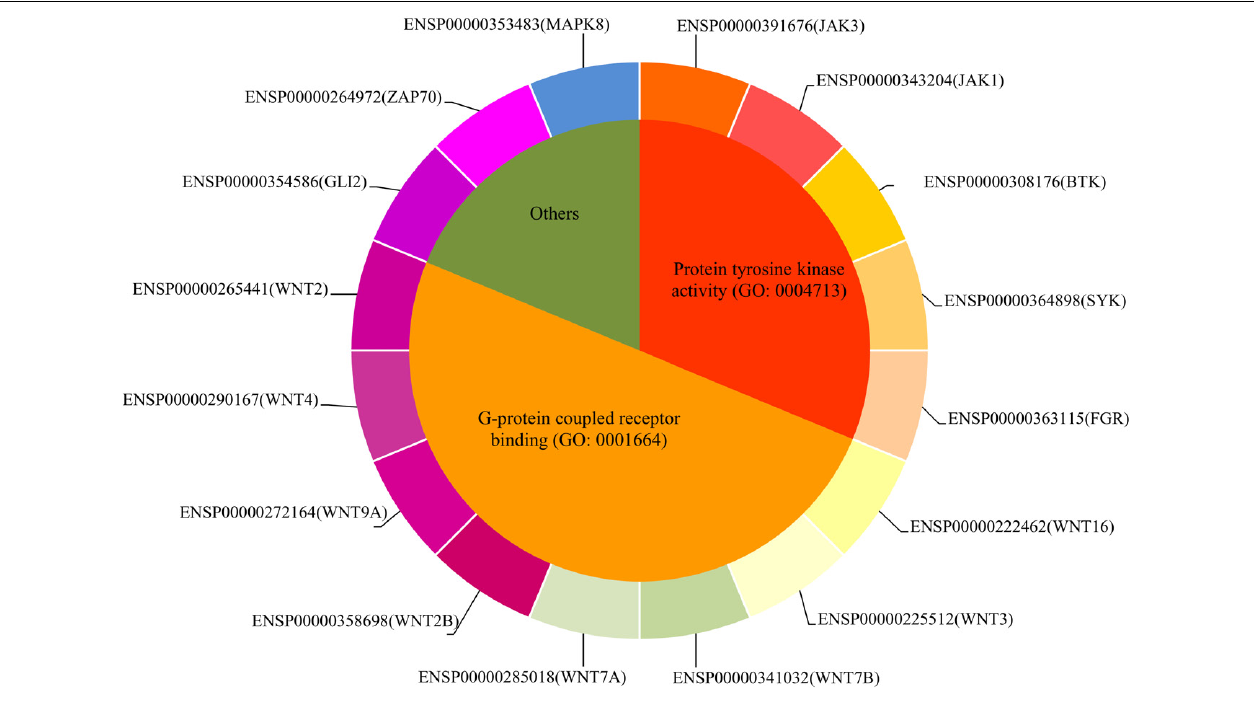
FIGURE 4 | The distribution of sixteen important inferred